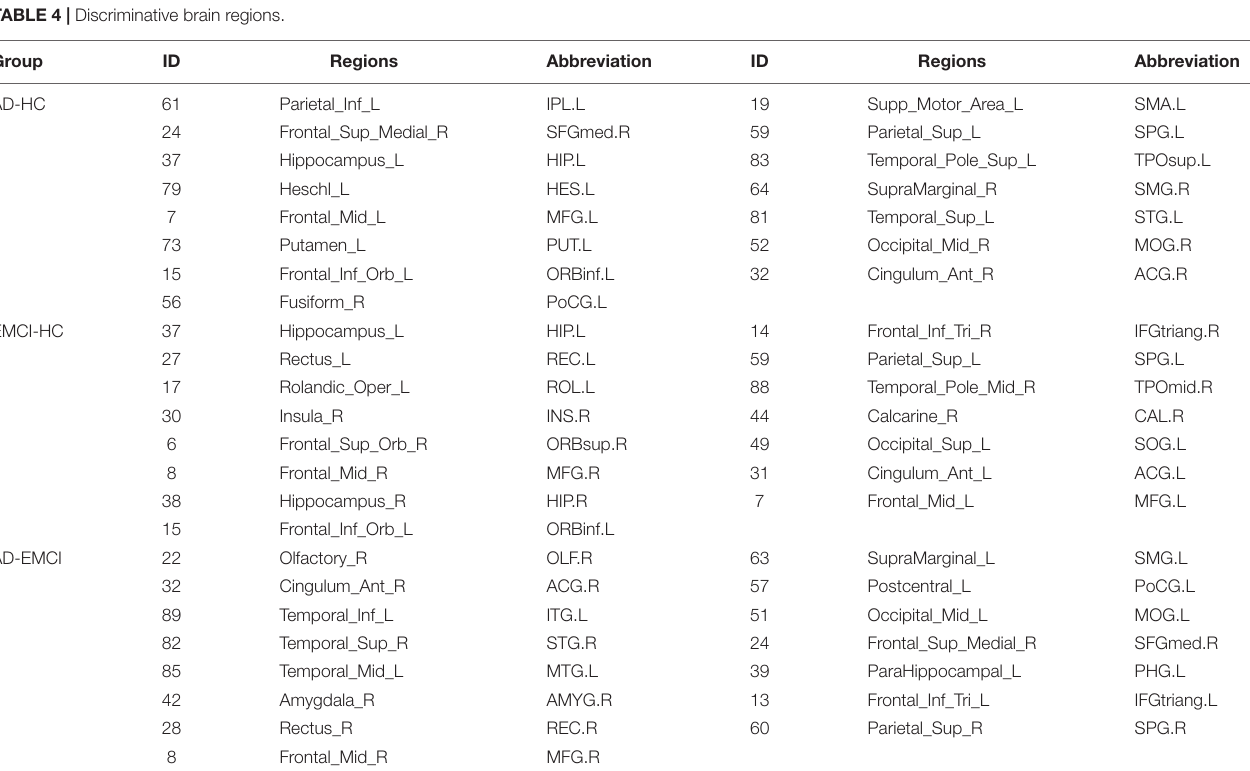
FIGURE 4 | The ROC curve of the five methods in three groups. (A) Prediction accuracy of AD-HC group. (B) Prediction accuracy of AD-EMCI group. (C) Prediction accuracy of EMCI-HC group. TABLE 4 | Discriminative brain